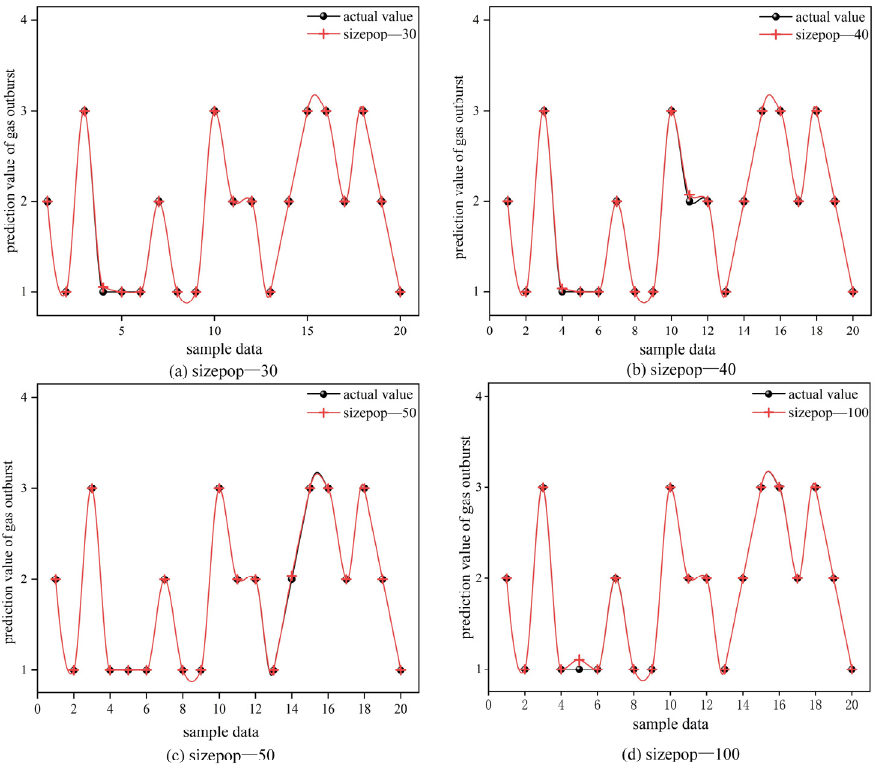
Figure 7. Predicted values of gas outburst risk from WOA-ELM model with different size pop.